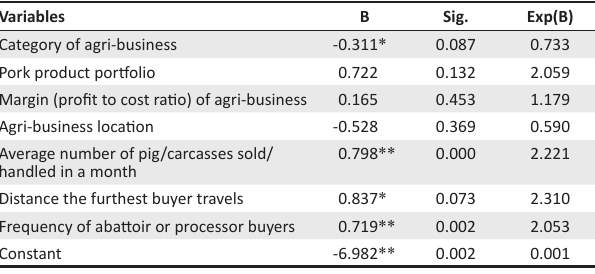
TABLE 3: Empirical binary logistic regression of determinants of choice between product and price marketing mix. Variables